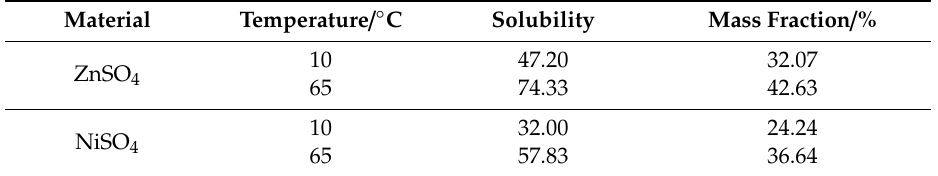
Table 1. Solubility and corresponding mass fraction of ZnSO 4 and NiSO 4 at di ff erent temperatures [22]. Material